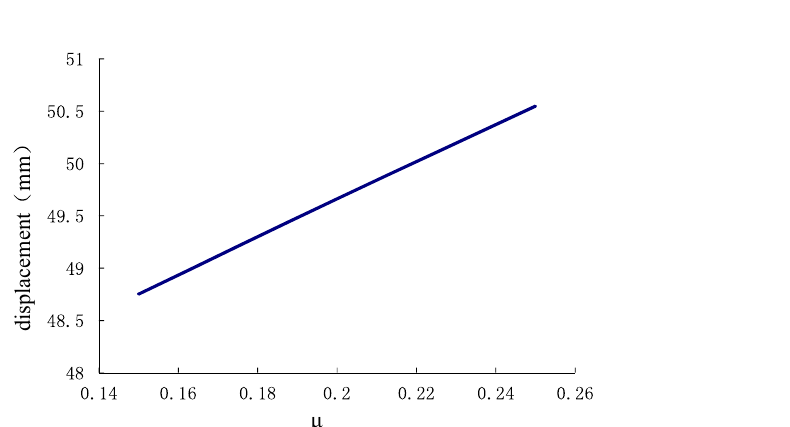
Figure 14. The effect of Poisson’s ratio µ (0.15–0.26) of the surrounding soil on the displacement of the anchor- pulling